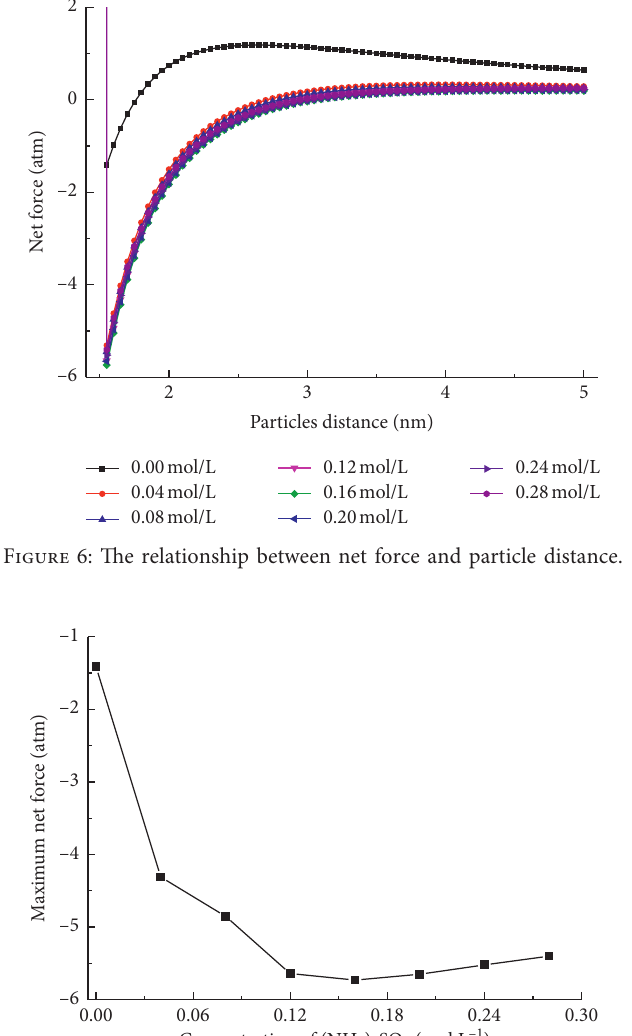
4 ) 2 SO 4 solution